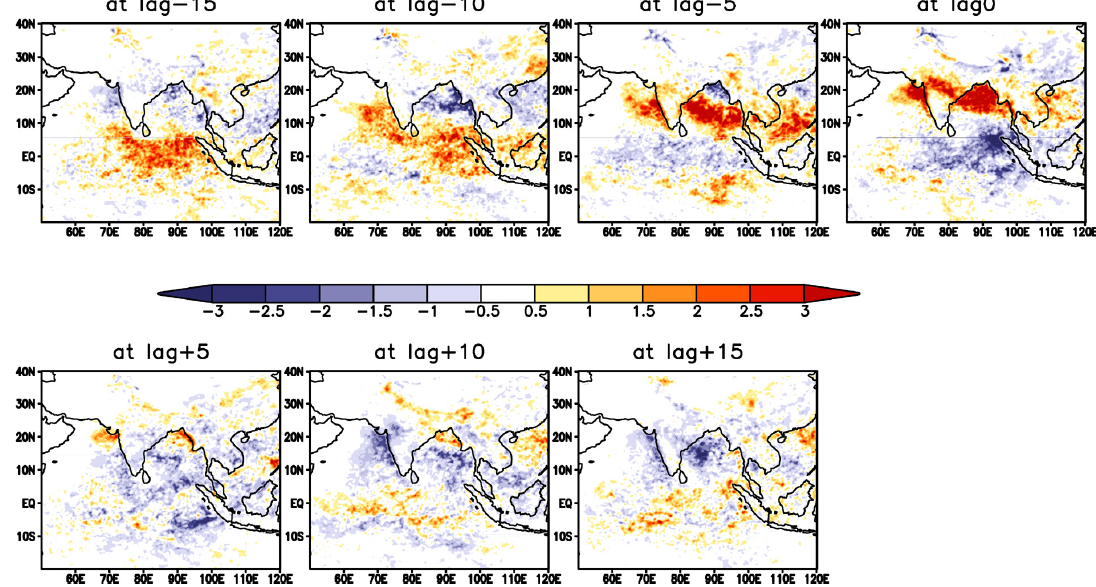
Fig. 6. Lag composite of cloud water (mgm − 3 day − 1 ) during active spells based on CIPI using TRMM 2A12 data for the period 1998–2008.